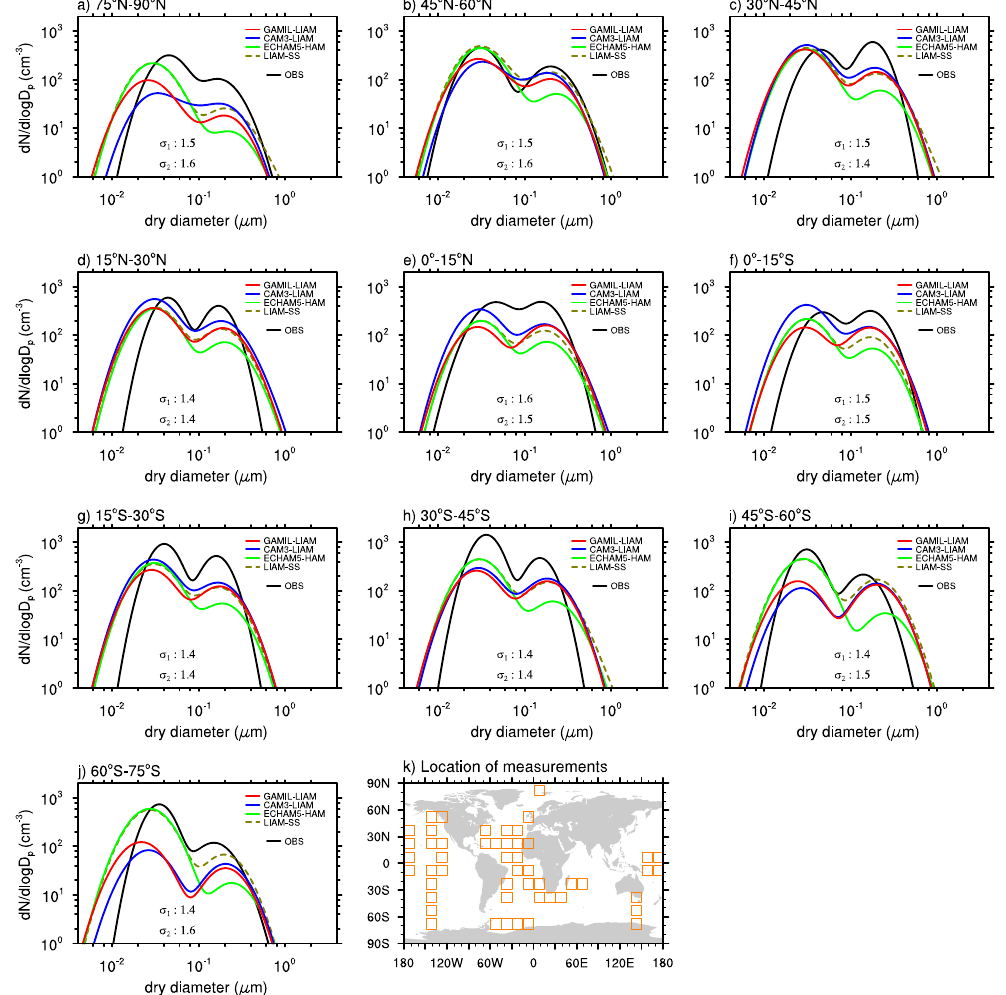
Fig. 12. Comparison between the simulated and observed aerosol size distributions of the Aitken and accumulation modes in the marine boundary layer. The simulated distributions include both the soluble and the insoluble modes. The observations were compiled by Heintzen- berg et al. (2000) (see Table 3